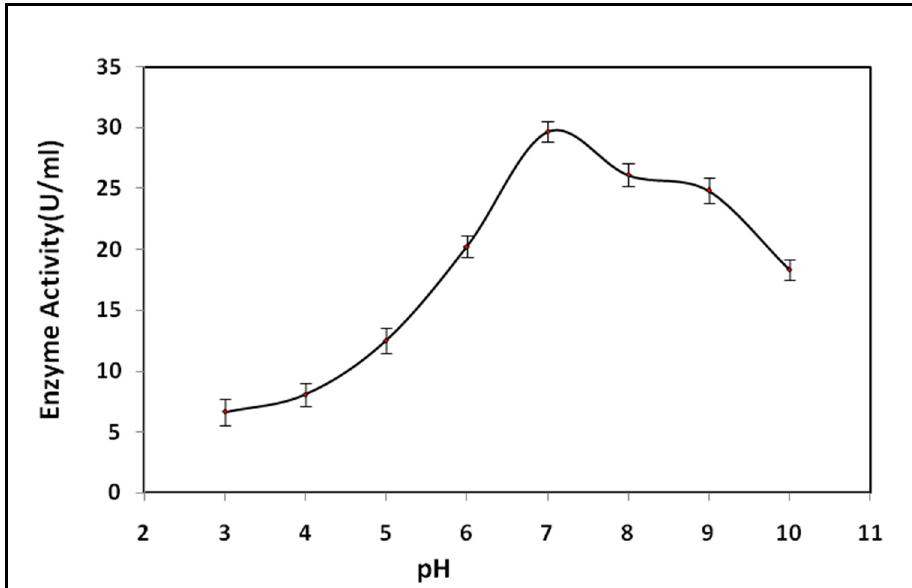
Figure 7. Effect of pH on lipase activity.